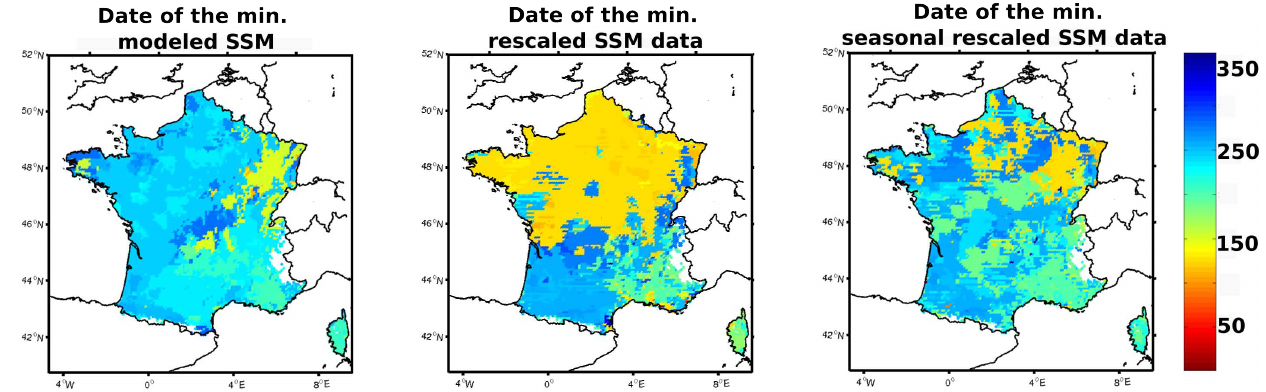
Fig. 3. Date of the lowest SSMmod values (left panel), CDF rescaled SSMsat (middle panel) and seasonal CDF rescaled SSMsat (right panel) for the year 2009 across the domain of France. The colour bar represents the days of the year.